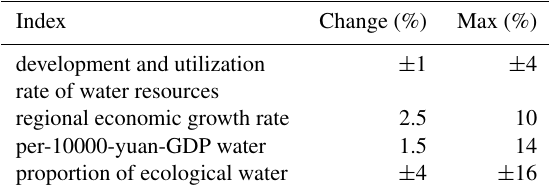
Table 2. The evaluation index system based on VFS.